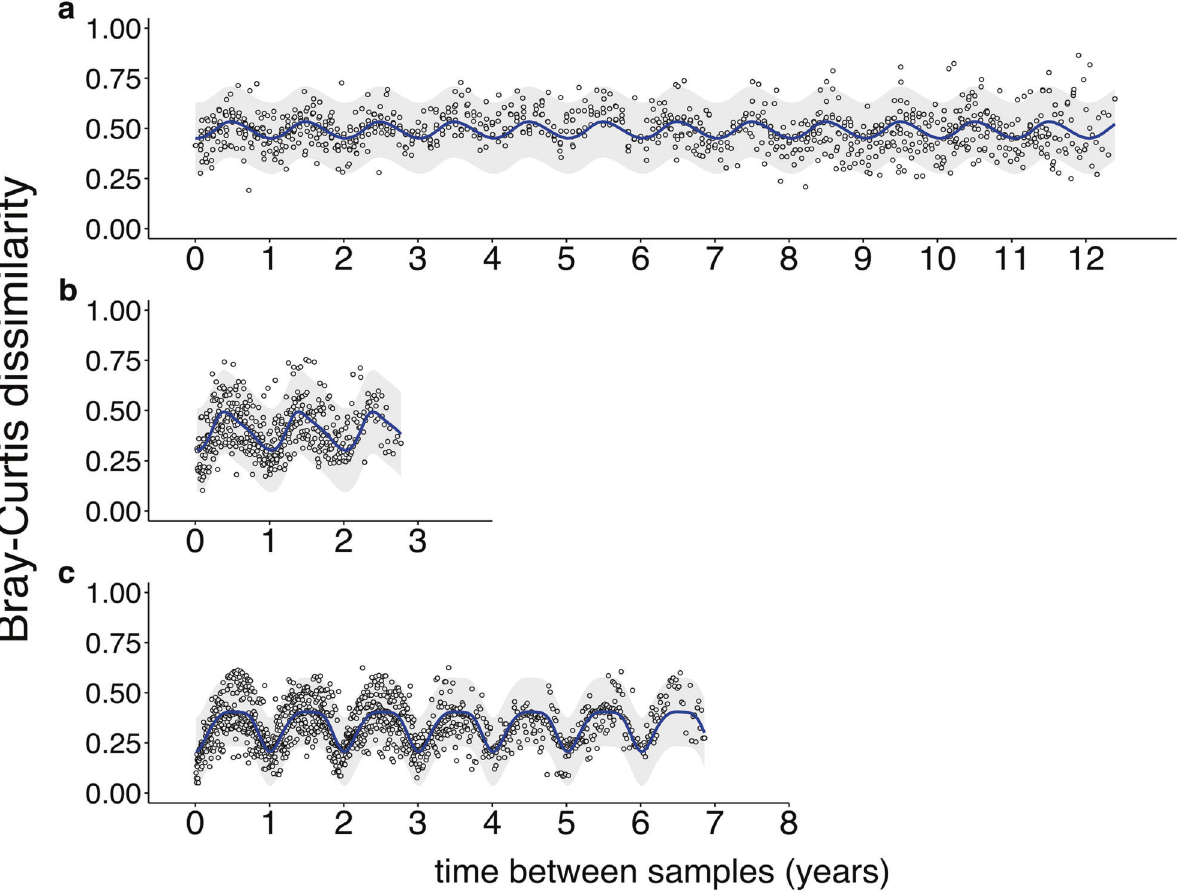
Fig. 3 Inter-annual patterns of Bray – Curtis dissimilarity between SAR11 ASV communities. Pairwise SAR11 community dissimilarity was estimated using the ASV rare fi ed datasets from BATS and WEC. Bray-Curtis dissimilarities were averaged to generate a one-to-one relationship between dissimilarity and time distance (time datapoint). a Average Bray – Curtis dissimilarities of BATS monthly samples from 1991 to 1994 and 1996 to 2002 sequenced using 454 FLX technology. b Average Bray – Curtis dissimilarities of BATS monthly samples from 2016 to 2018 sequenced using the Illumina MiSeq platform. c Average Bray – Curtis dissimilarities of WEC weekly samples from 2012 to 2018. The blue curve in the three panels represents a periodic spline fi t (df = 4) on the Bray-Curtis dissimilarities estimated on a regular interval of 366